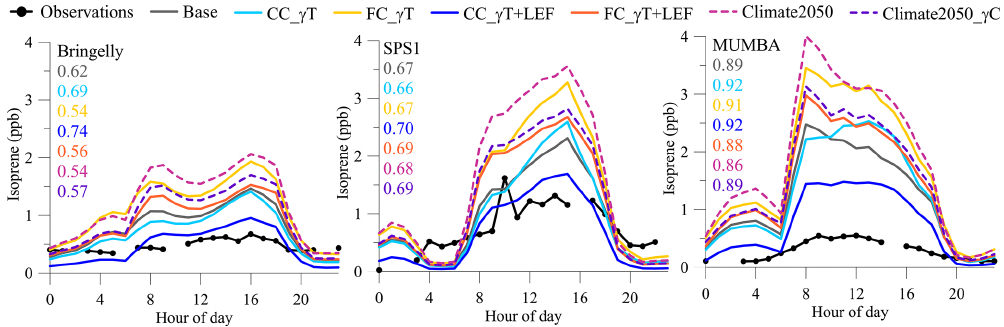
Figure 4. Average diurnal time series in isoprene mixing ratios incurred by the different model experiments at each field campaign site. r 2 values between modelled and observed isoprene given in the same colours as the